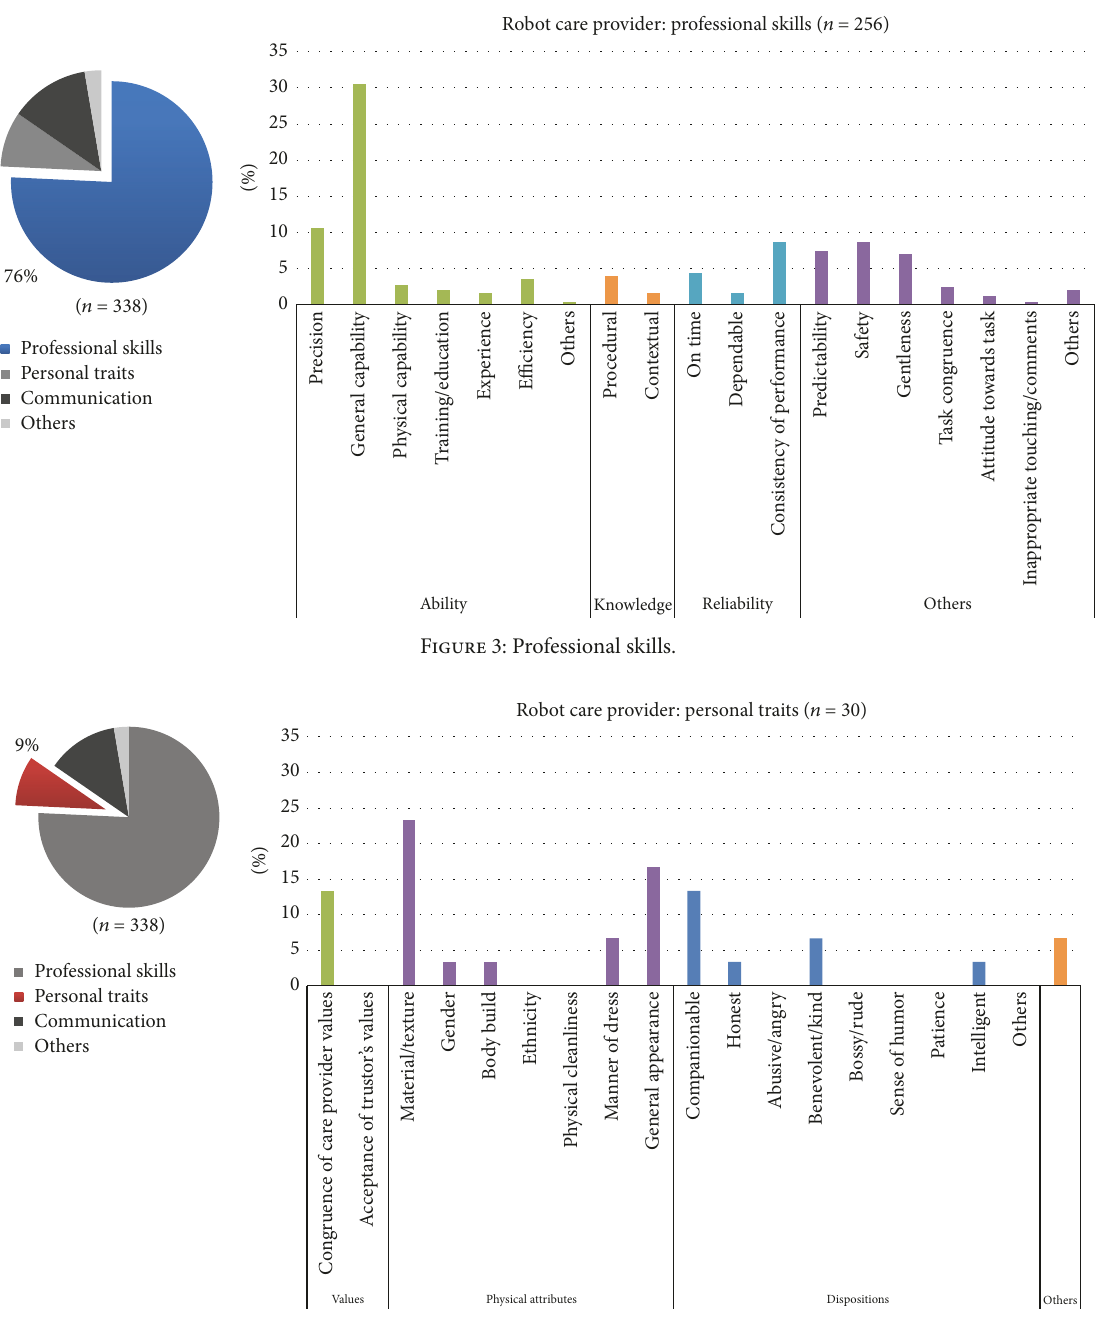
Figure 4: Personal